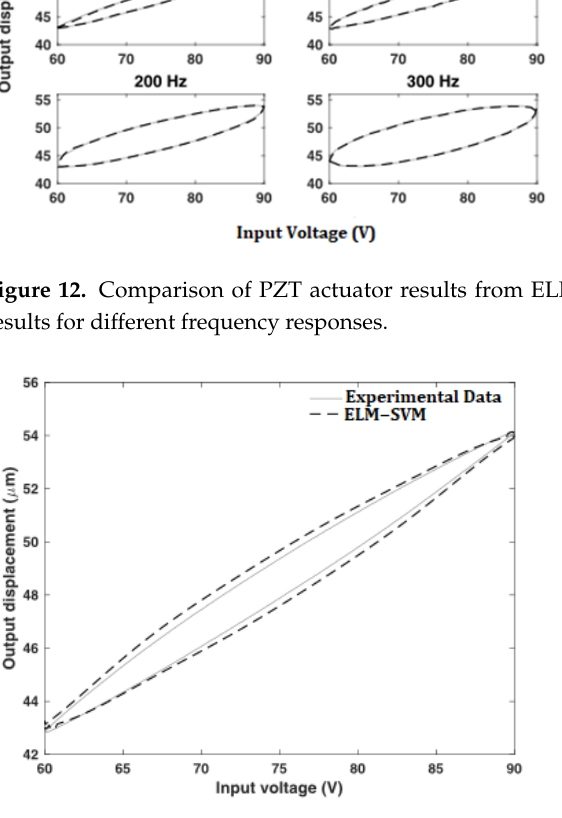
Figure 13. The testing the PZT actuator on the 10 Hz input signal and comparing the results of experimental [38] with the ELM − SVM method results.